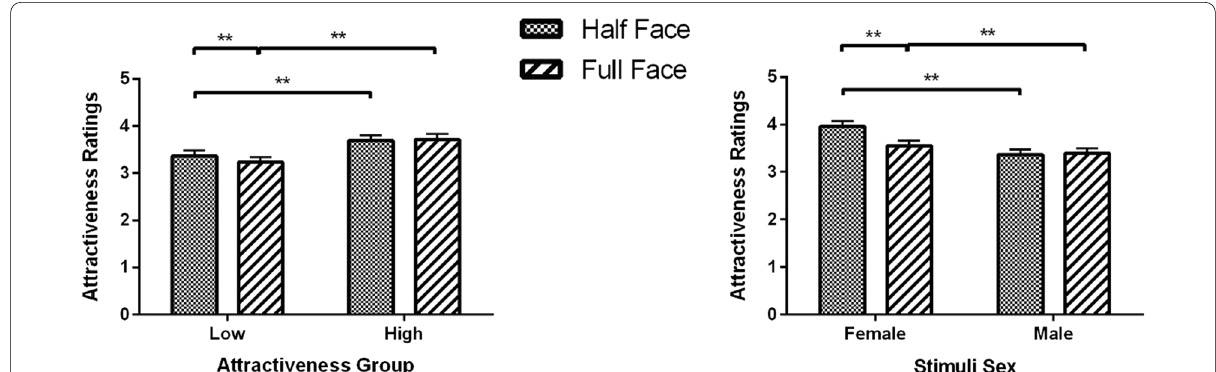
Fig. 6 Attractiveness ratings (Means and SEM) for upper half and full faces as a function of attractiveness group and stimuli sex. * p < 0.05, ** p <